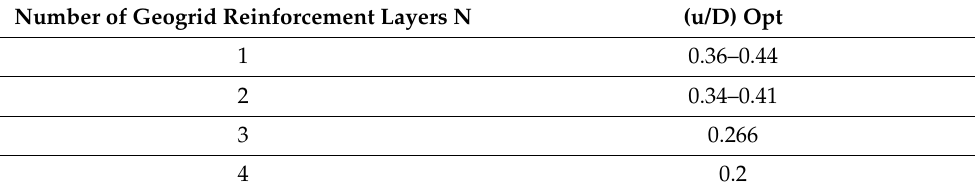
Table 3. The optimum depth to lay the top geogrid